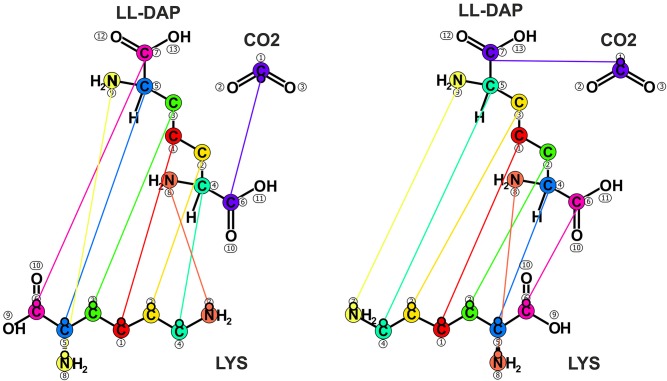
Scrambling reaction. Carbon-nitrogen mapping variants for the diaminopimelate decarboxylase reaction catalyzing the decarboxylation of LL-2,6-diaminopimelate (LL-DAP) to L-lysine (LYS) and CO2. Due to its rotation symmetry, LL-DAP has two biochemically indistinguishable carboxyl groups, resulting in two different mapping variants.